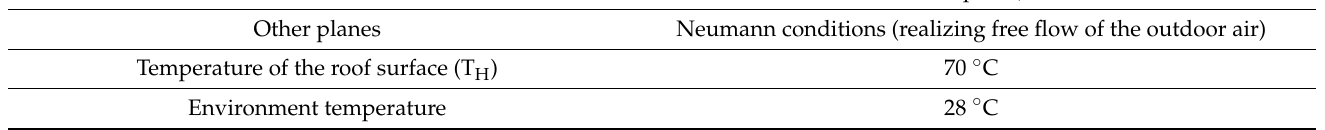
Table 2. Parameters specified in the numerical calculations. (Figure